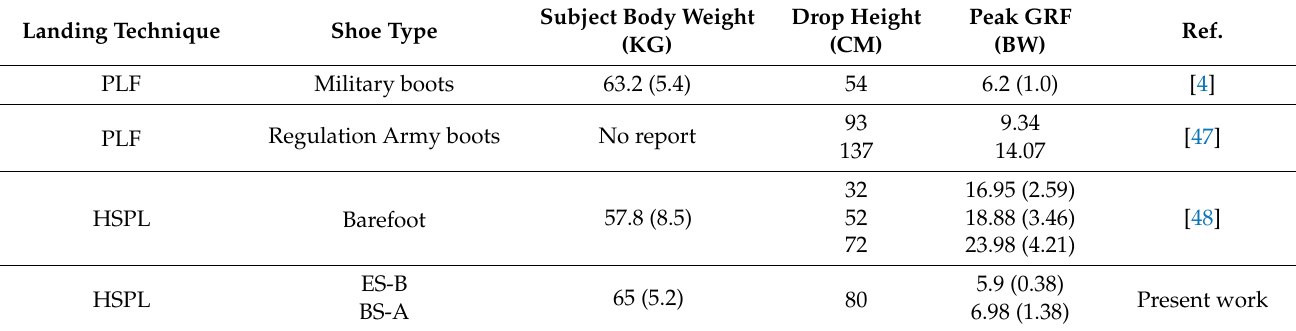
Figure 12. Peak vertical GRFs of different soles at different heights. Table 1. Mean and standard deviation of peak vertical GRFs for five soles from drop landing tests Table 2. Peak vertical GRFs from parachute landing at heights of 40 cm and 80 cm.